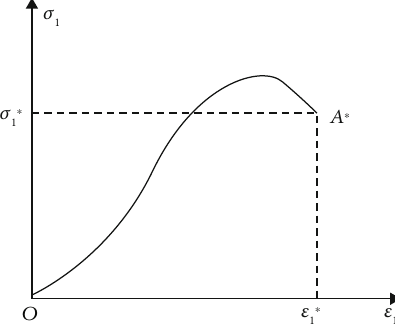
Figure 7: The stress-strain curve of coal in the postpeak stage.